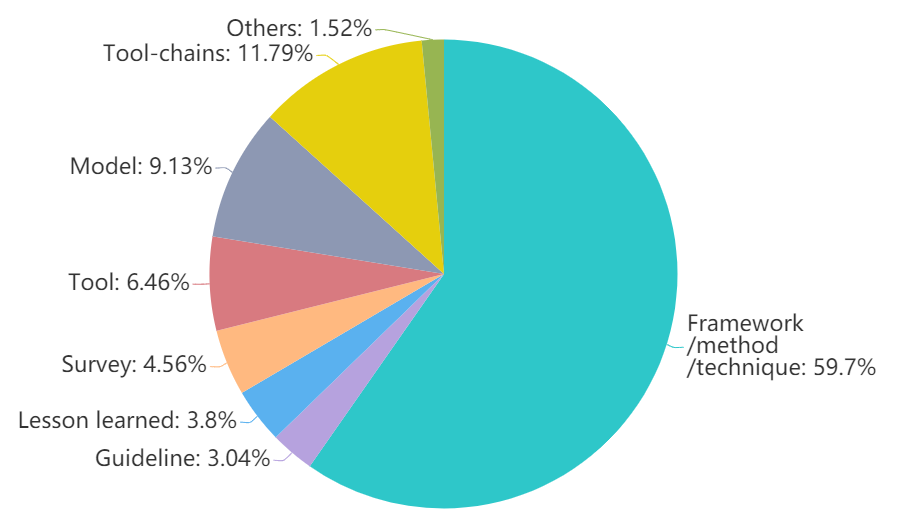
Figure 18. Contributions of